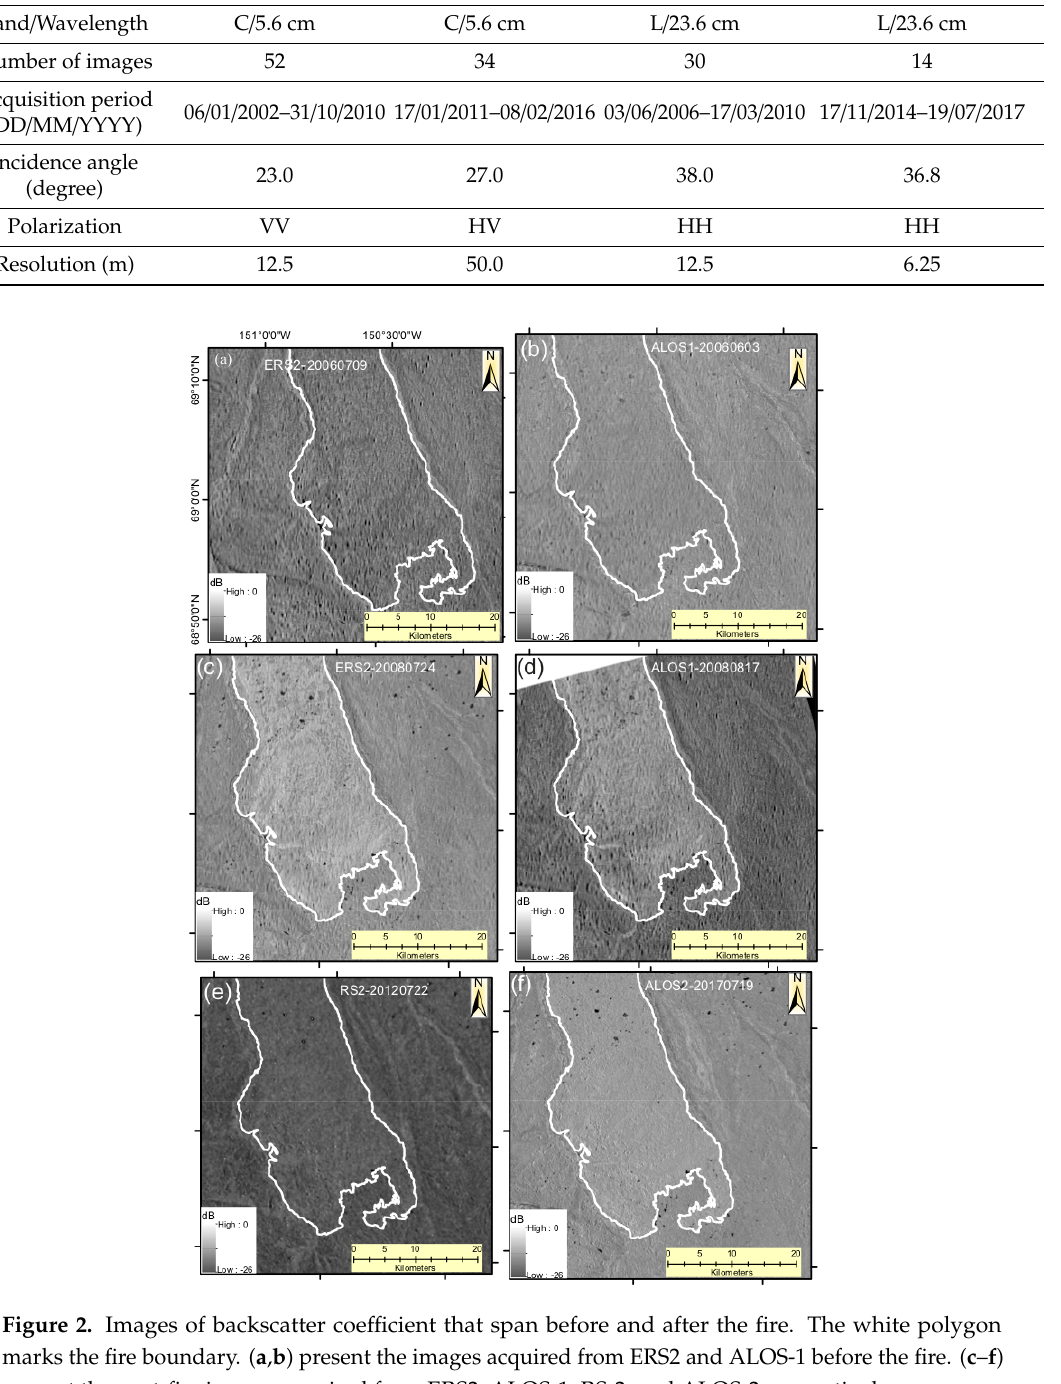
Table 1. List of synthetic aperture radar (SAR) images used in this study. Note: the resolution is equal in range and azimuth direction.